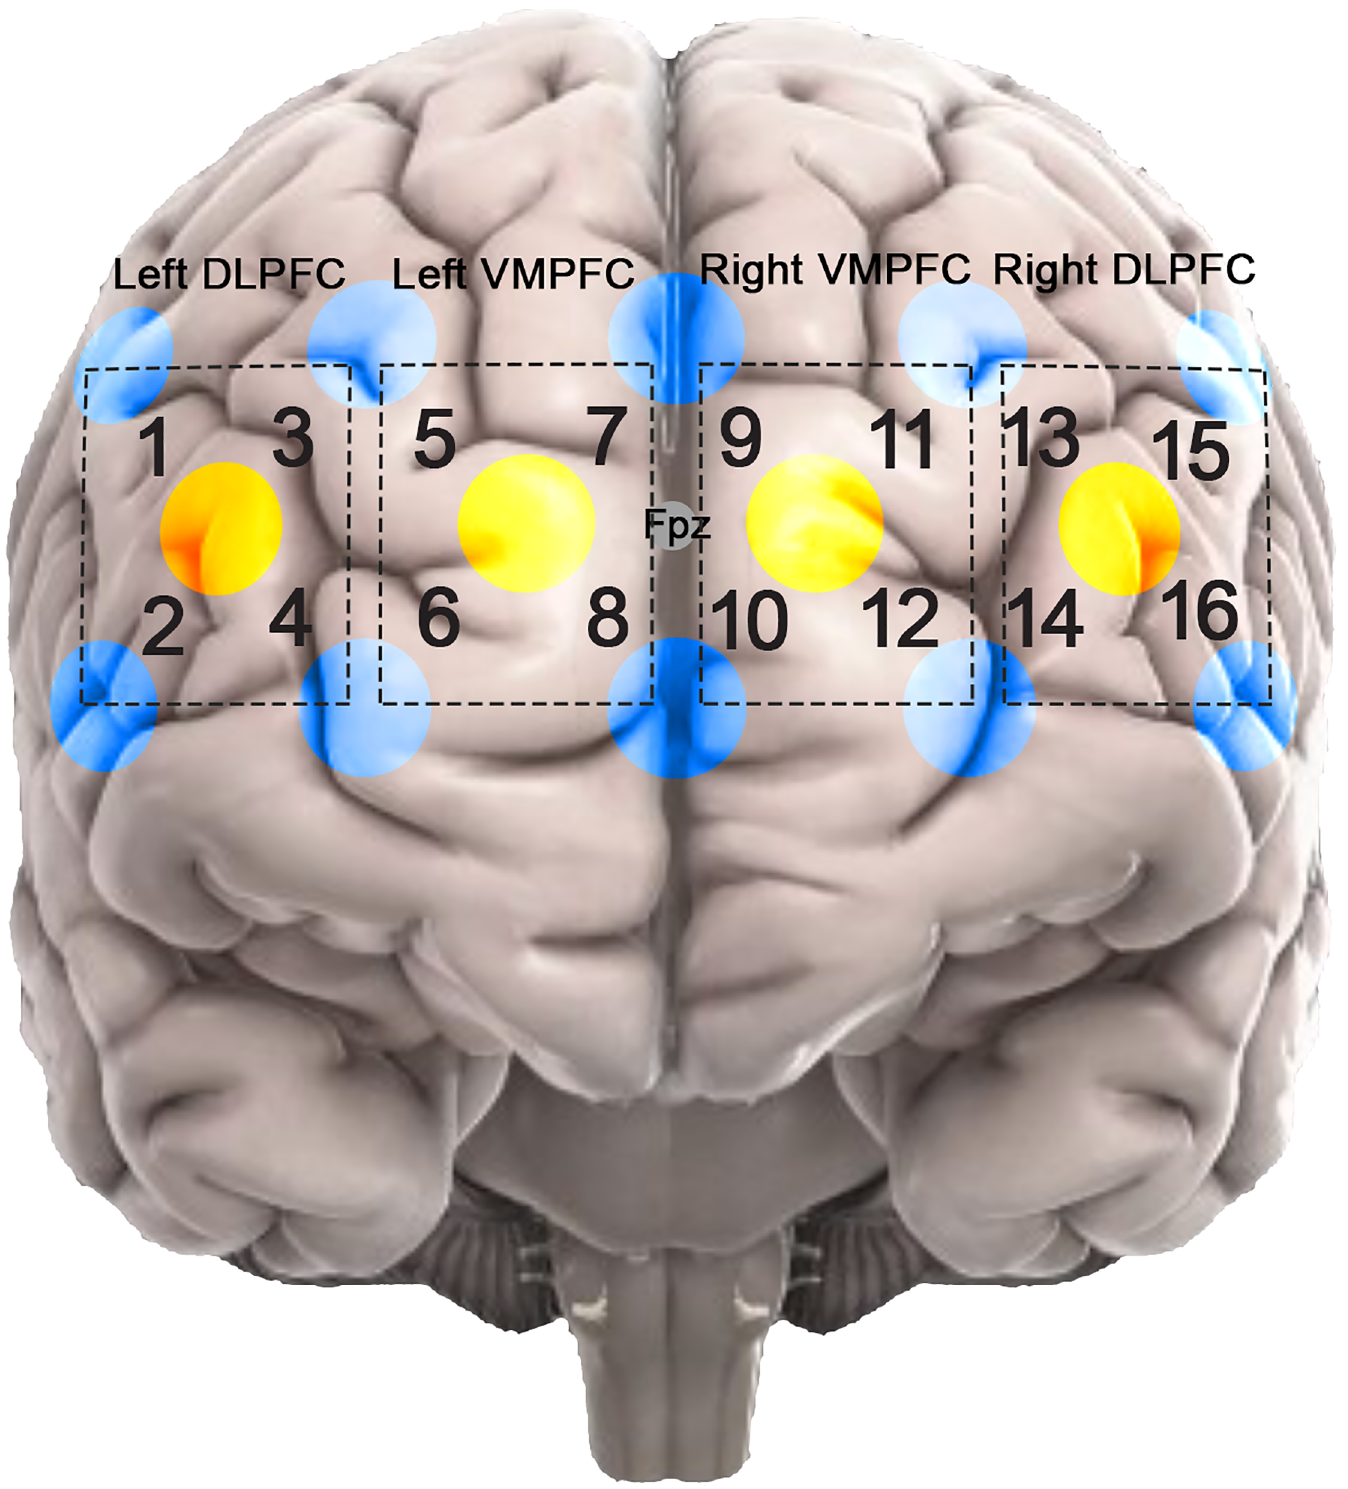
Fig 2. Sensor position on the prefrontal cortex region with respect to Fpz (International 10–20 system). Yellow dots: Sources, Blue dots: Detectors. Numbers indicate the loaction of the channels based on the source-detector pairs. The dotted squares indicate channel parinings.